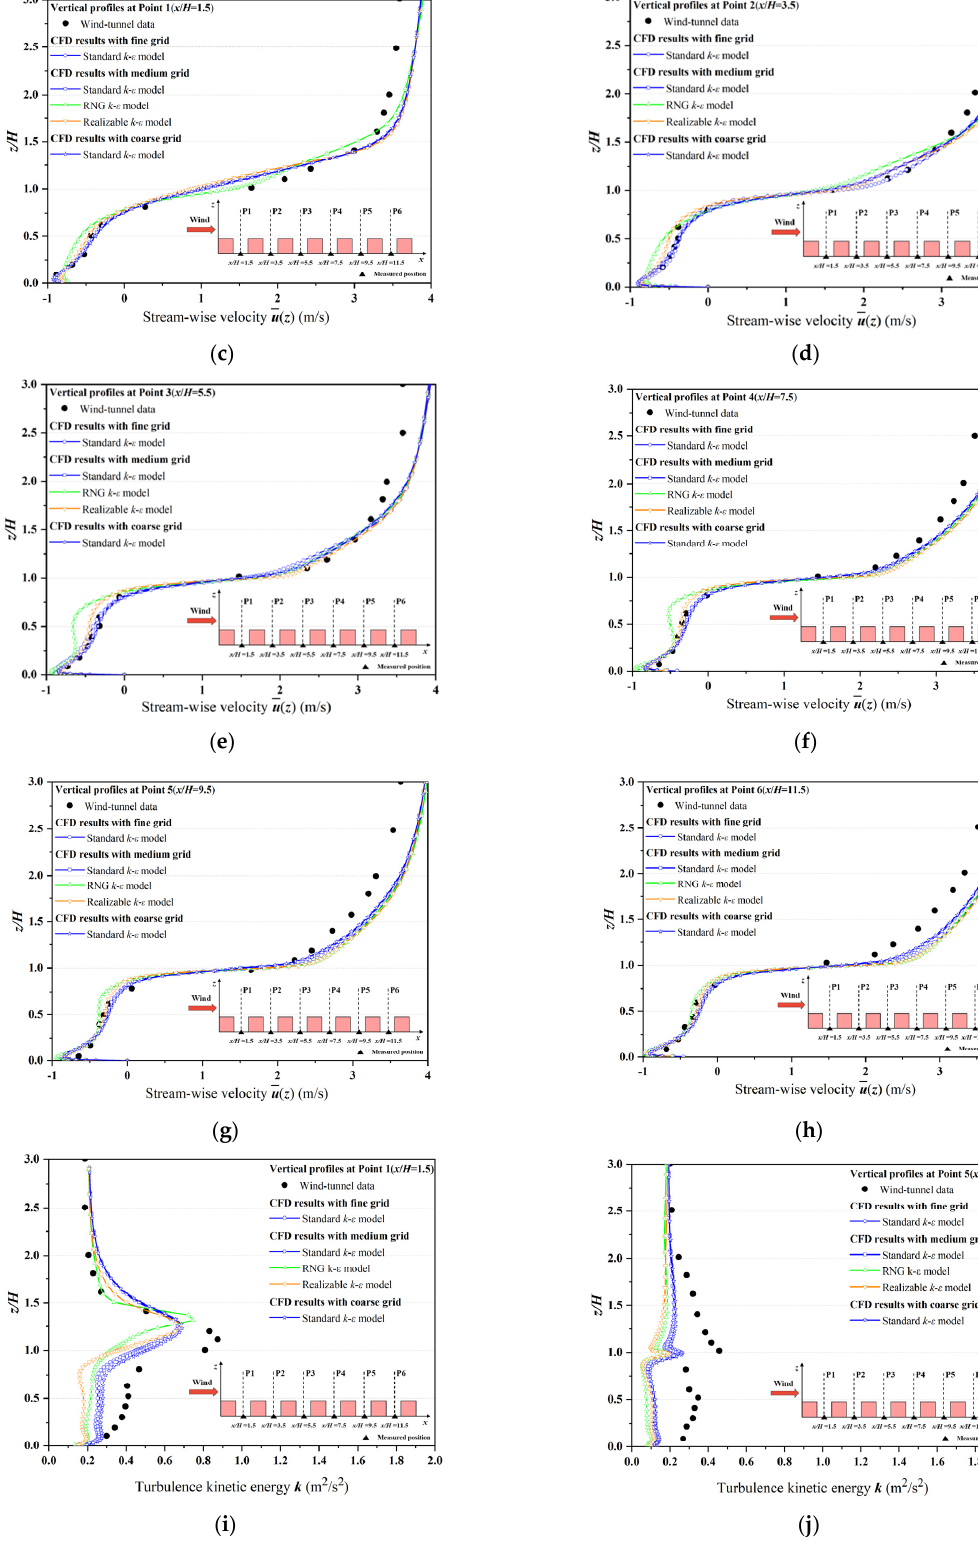
Figure A1. Flow validation by wind tunnel data. ( a ) Geometry of the UCL model in wind tunnel dataset. ( b ) Setting of the computational domain and boundary conditions. ( c – h ) Vertical profiles of monitored and modelled stream ‐ wise velocity ( 𝑢(cid:3364) ) at Point P1–P6. ( i , j ) Vertical profiles of monitored and modelled turbulence kinetic energy ( k ) at Point P1 and P5. Table A2. Statistical analysis between wind tunnel data and CFD simulation results—flow valida ‐ tion.